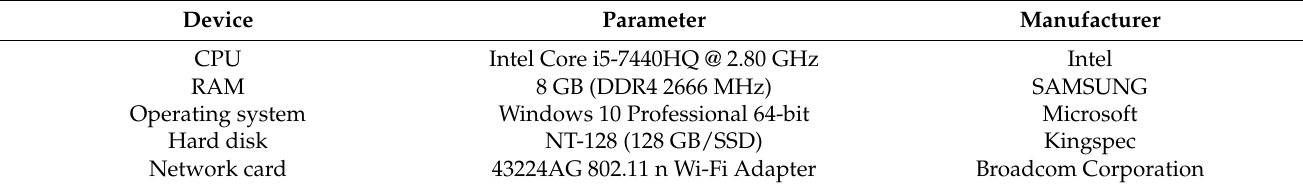
Table 2. Industrial control computer performance